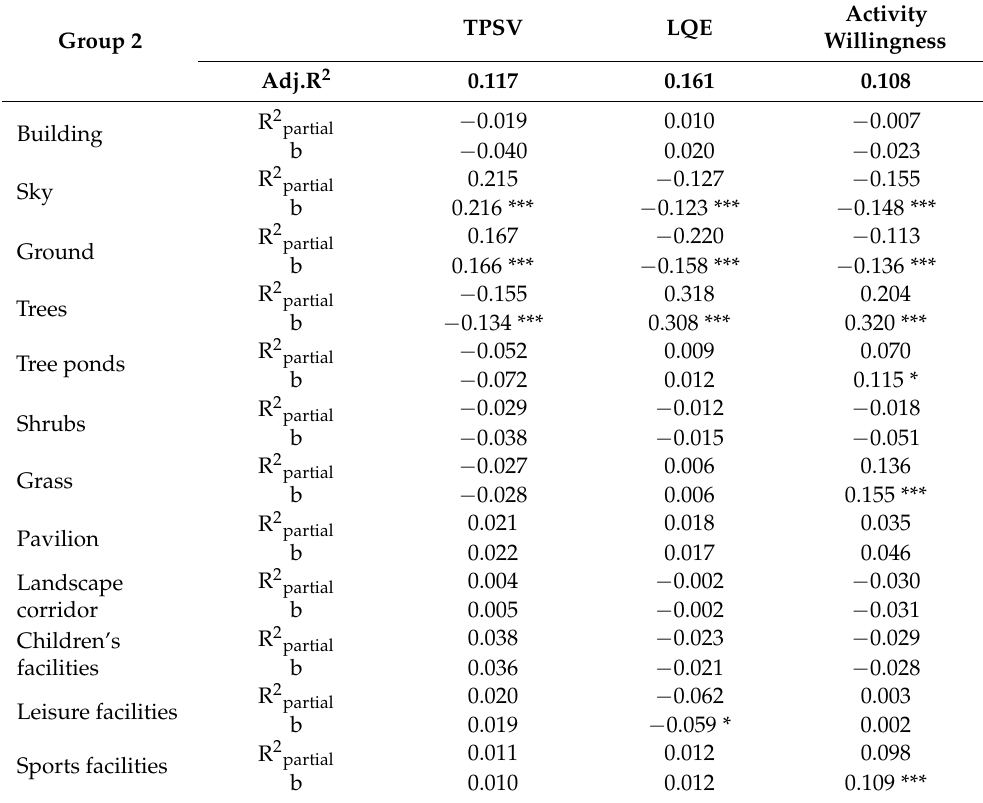
Table 10. Regression coefficients (%) of landscape parameters with TSPV from Group 2